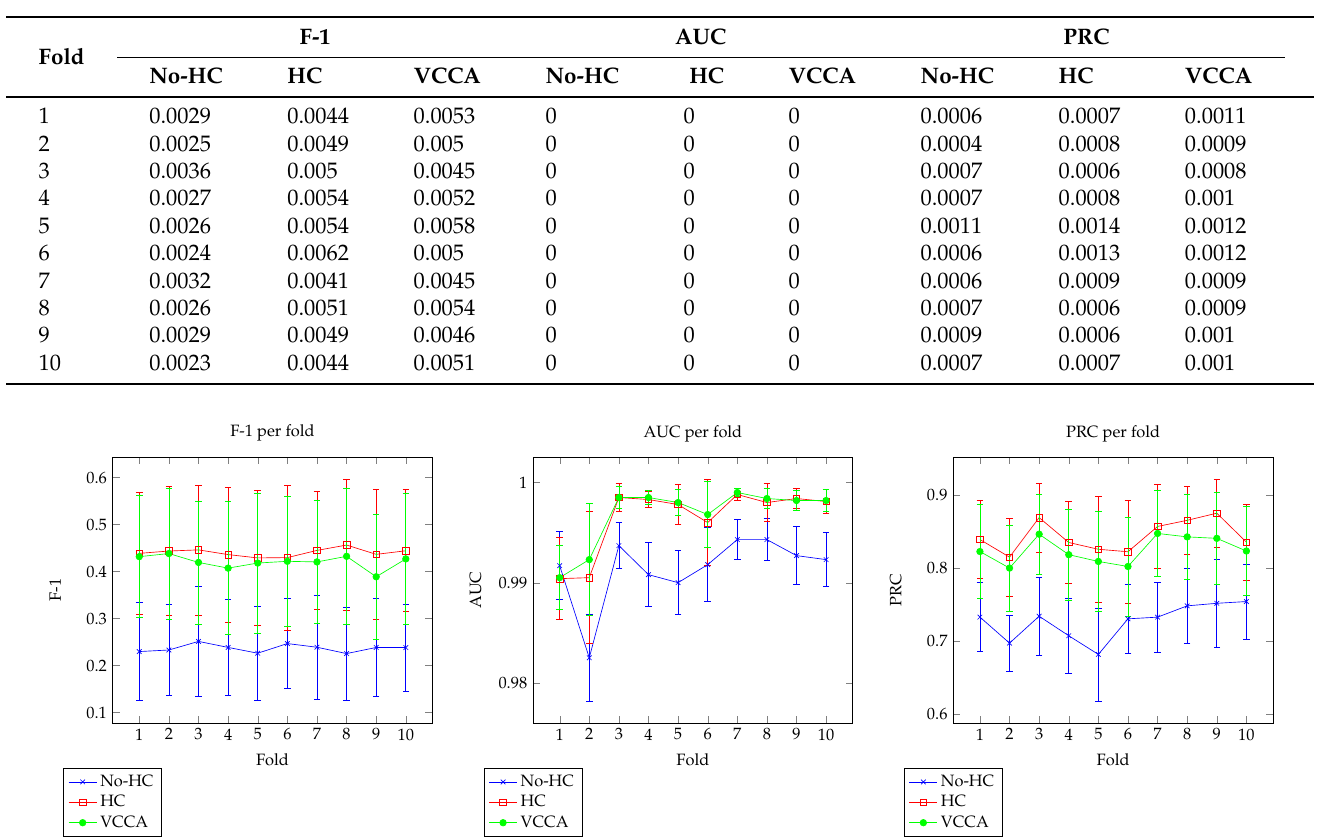
Table 16. The Variance of Metrics from Dataset 3.